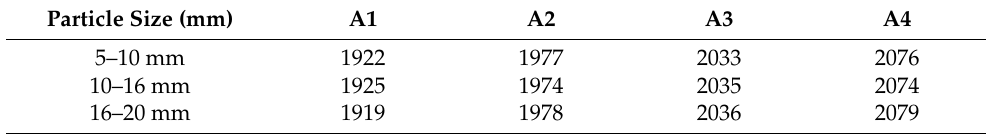
Table 7. The apparent density of SFLAs with different particle sizes (kg · m − 3